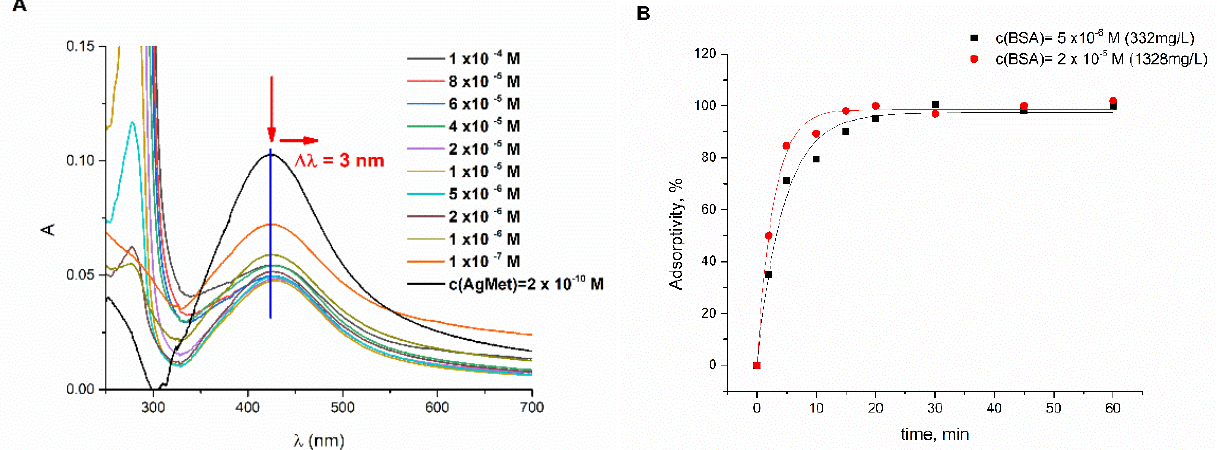
Figure 1. ( A ) The absorption spectra of 2 × 10 − 10 M AgMet in 10 mM phosphate buffer pH 7.4, in the absence (black line) and in the presence of the increasing concentration of BSA (1 × 10 − 7 –1 × 10 − 4 M). ( B ) The dependence of the adsorptive capacity of 2 × 10 − 10 M AgNPs as the function of time and the BSA’s concentration.